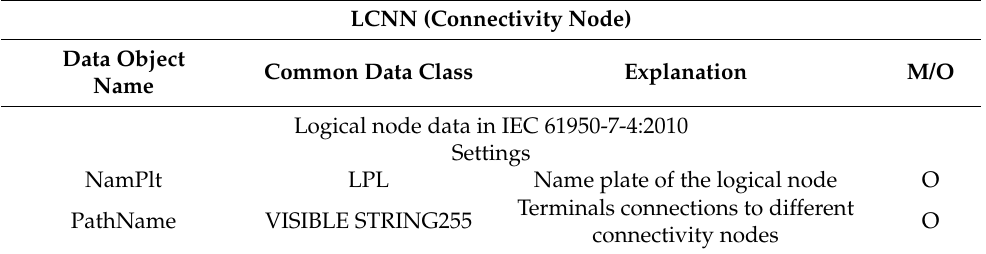
Table 3. Logical node LCNN.